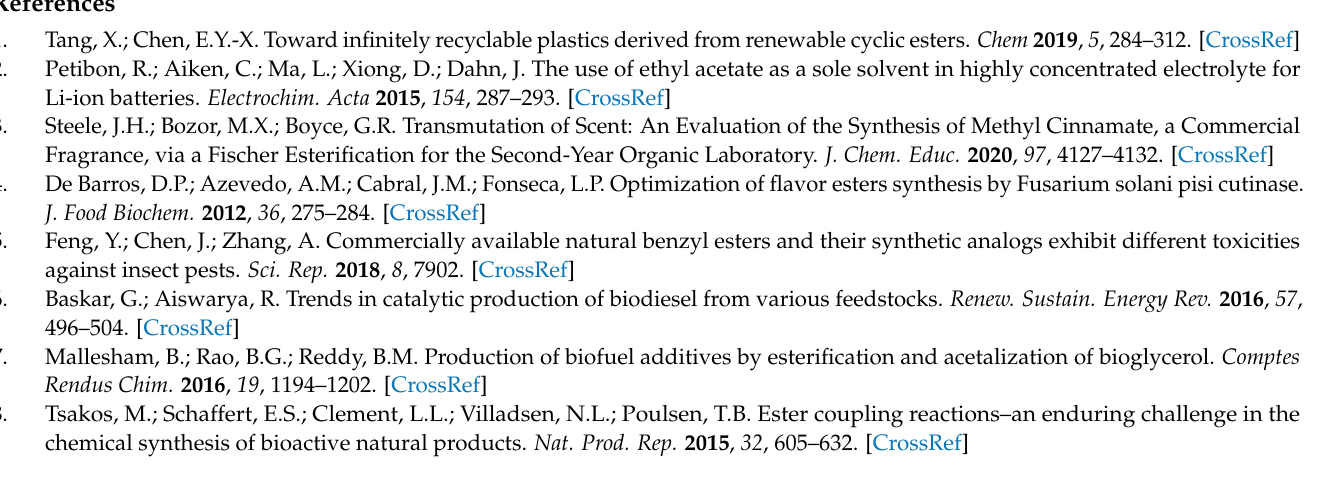
results; Table S2: Coefficients for quadratic equation. Figure S1: 2D plot obtained after RSM analysis and numerical optimization; Figure S2. Energy input (gray line—power [W]) and temperature (blue line—in ◦ C) for esterification under optimal reaction conditions and MW irradiation. List S1. NMR spectral data of synthesized esters. List S2. 1 H and 13 C NMR spectra of synthesized esters. List S3. 19 F NMR spectra of NFSi (A) and crude reaction mixture of cinnamic acid, MeOH and NFSi (B).